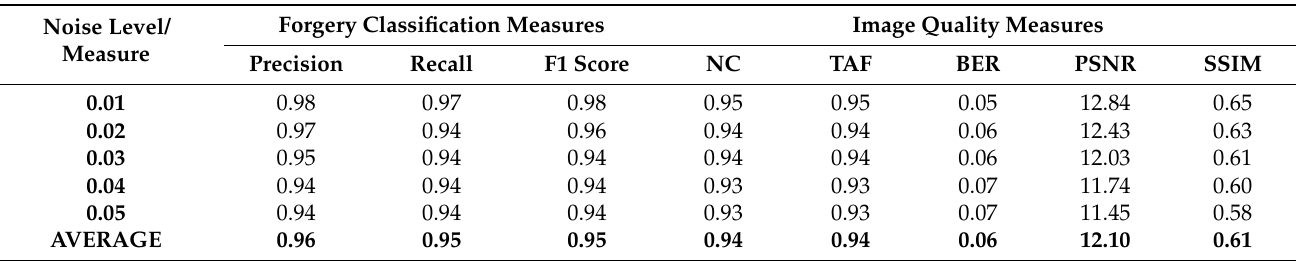
Table 3. Forgery classification and image quality measure values for the second group of experiments (Noise attack).